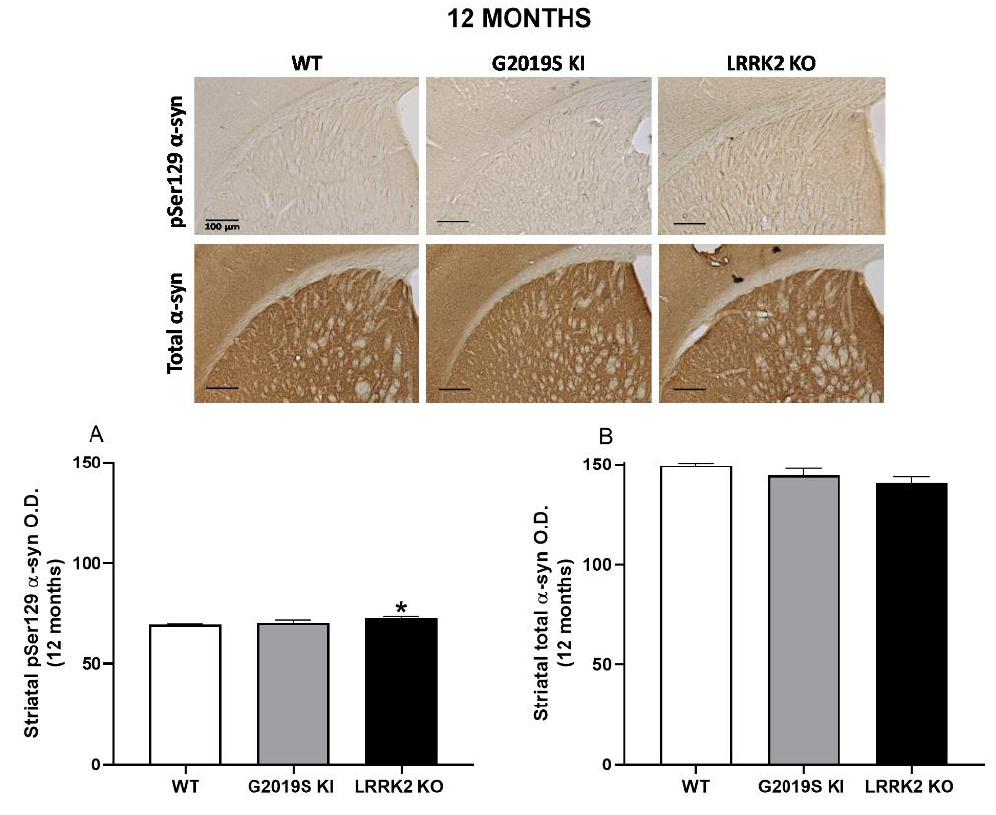
Figure 7. pSer129 α -synuclein levels are elevated in the striatum of 12-month-old LRRK2 KO mice. Immunohistochemistry was performed in striatal slices of 12-month-old G2019S KI and LRRK2 KO mice in comparison with age-matched WT mice. Optical density (O.D.) of pSer129 α -syn ( A ) and total α -syn ( B ) immunostaining was calculated. Data are expressed as mean ± SEM of n = 6 mice per group. Representative images were provided in the upper panels (scale bar = 100 µ m). Statistical analysis was performed by ANOVA followed by the Tukey test for multiple comparisons. * p < 0.05 different from WT mice.